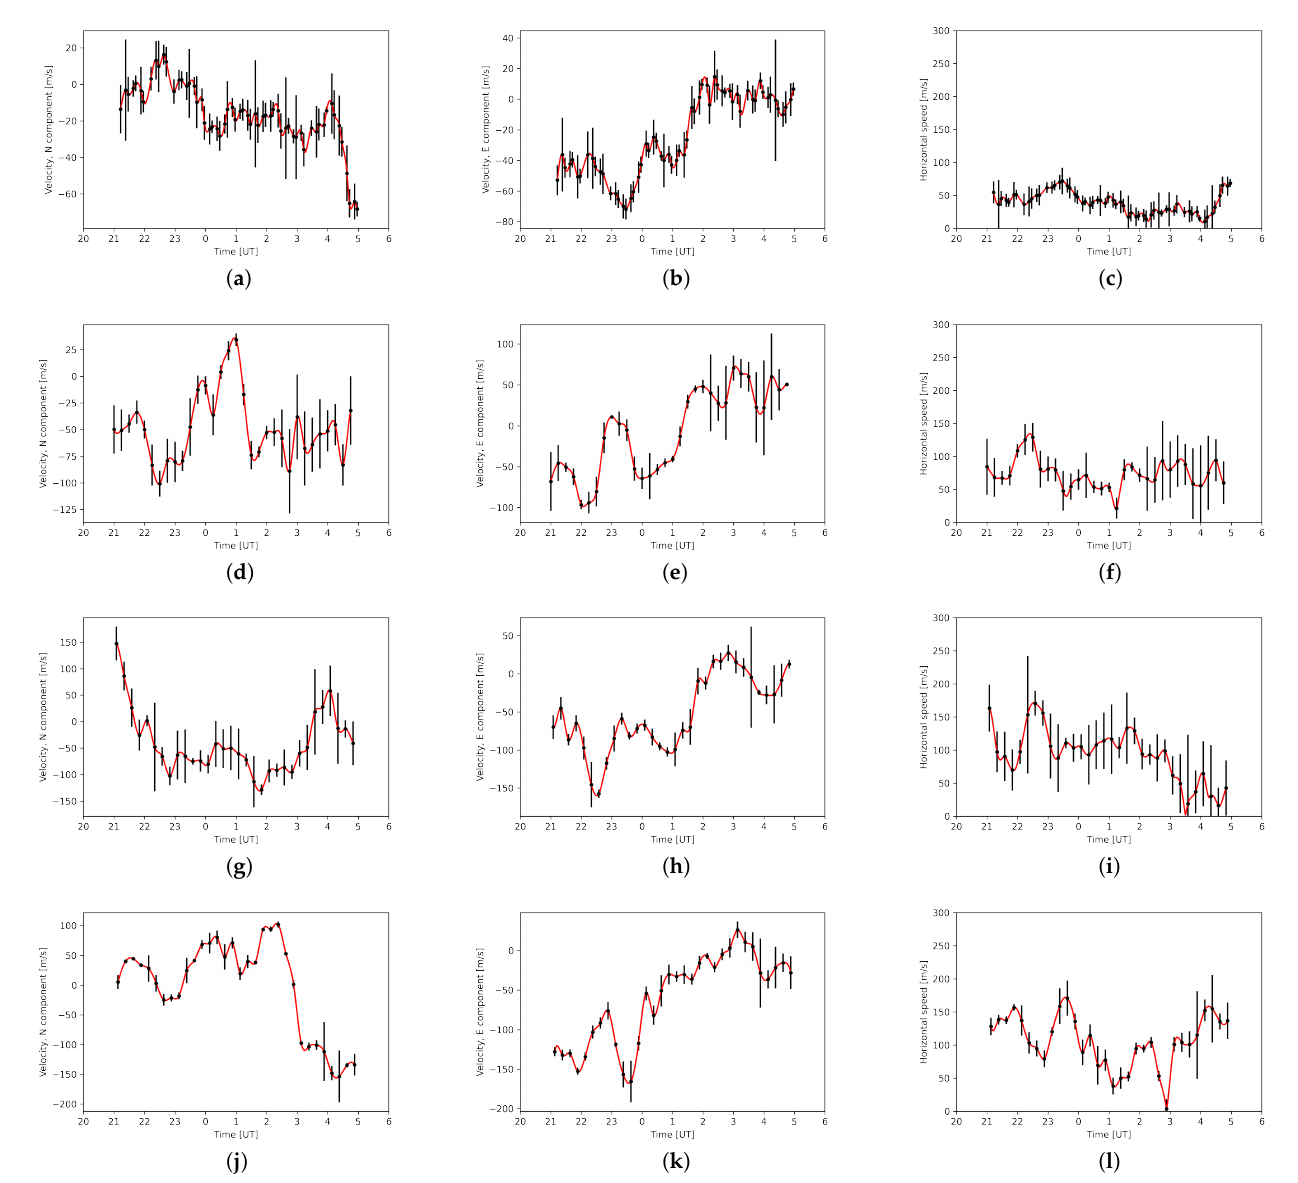
Figure 15. F layer plasma drift velocity data for L82655 with interpolated values (red line) for the North component, East component and horizontal speed of ( a – c ) DB, ( d – f ) JR, ( g – i ) PQ and ( j – l ) FF stations,